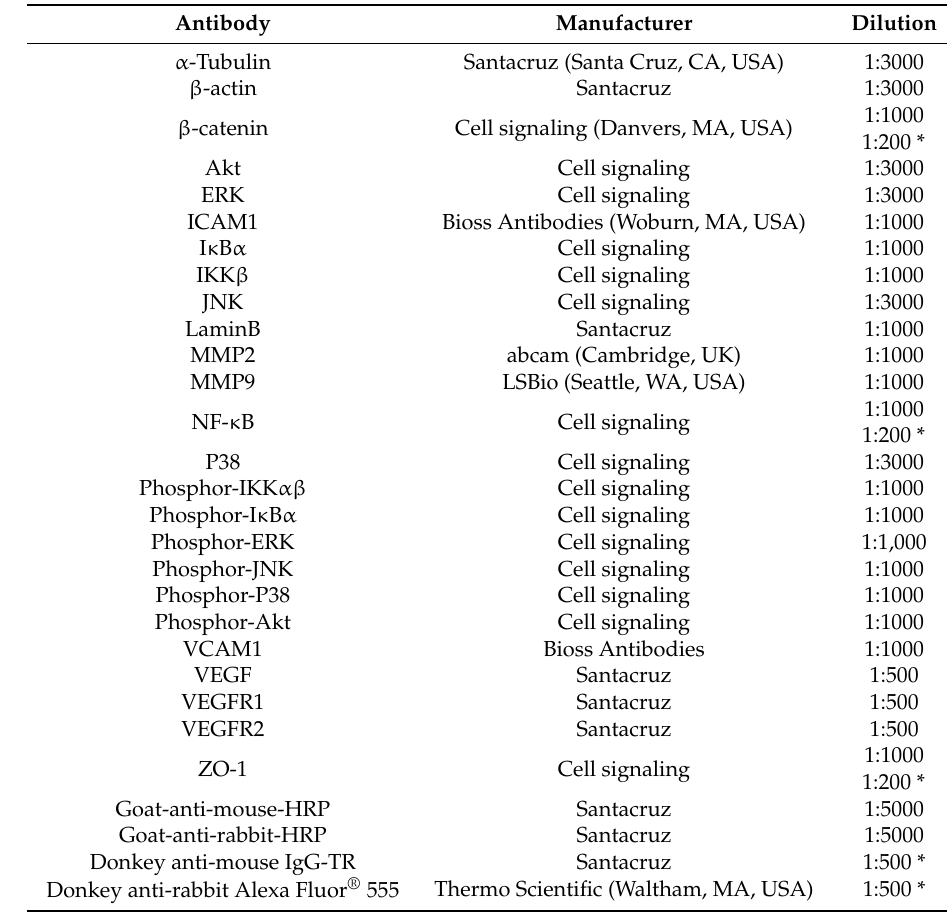
Table 1. Information of primary